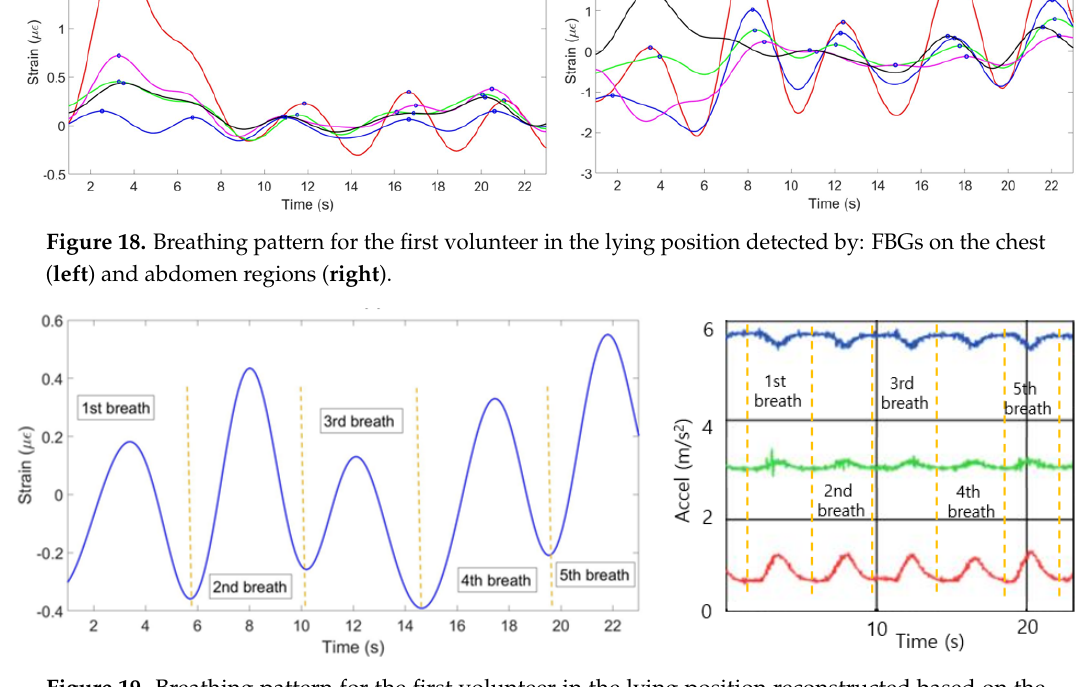
Figure 19. Breathing pattern for the first volunteer in the lying position reconstructed based on the 10 FBGs strain patterns ( left ) and obtained from the reference sensor ( right ).